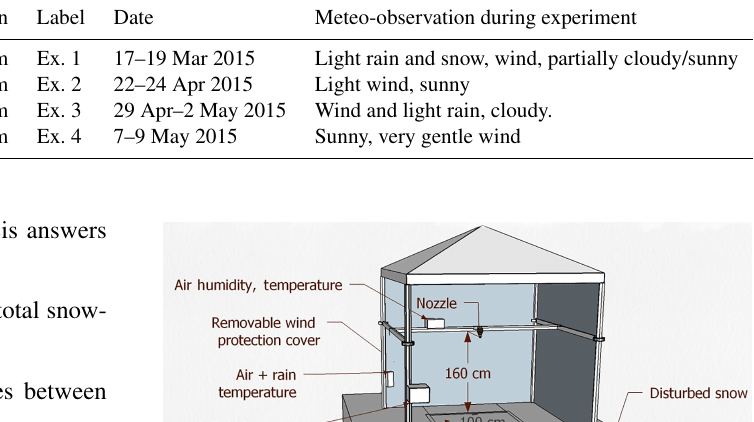
Table 1. Details of the experiments. Site Latitude Longitude Elevation Label Date Meteo-observation during experiment